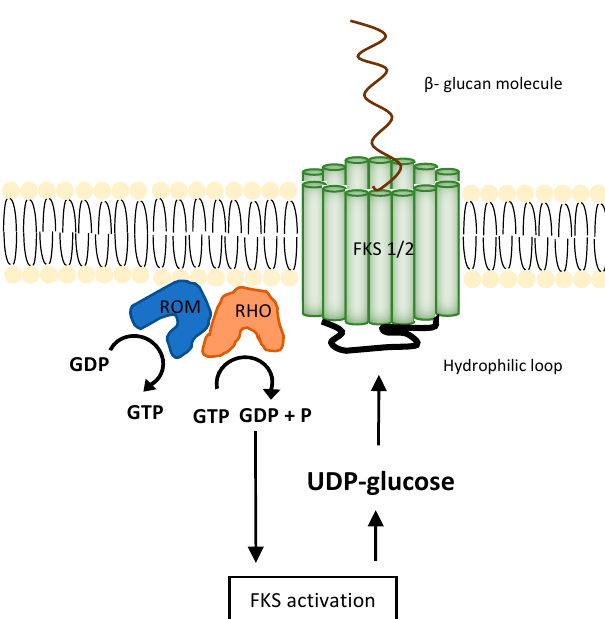
Figure 3. Schematic representation of β -glucan synthesis in the fungal cell wall by GLS protein complex. FKS 1/2 subunit catalyzes the elongation of the growing β -glucan chains by adding UDP-glucose monomers. The endoplasmic, hydrophilic loop, is one of the domains considered responsible for catalysis. RHO is a GTP-dephosphorylase protein, regulating the action of FKS 1/2 by GDP. ROM is a cell wall associated, GDP-GTP exchange protein, responsible for the regeneration of GTP.